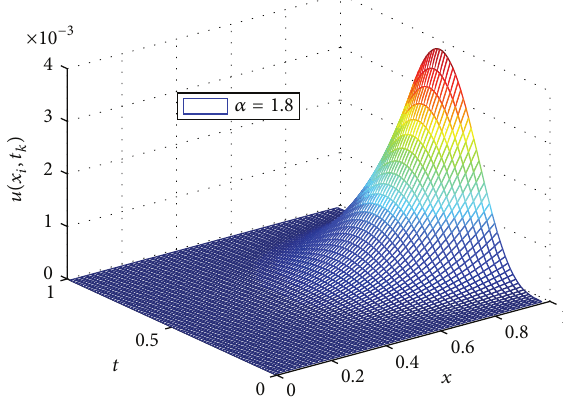
Figure 5: The numerical solution surface when 𝛼 = 1.8 in Example 3 (𝜏 = 1/50, ℎ = 1/80) .